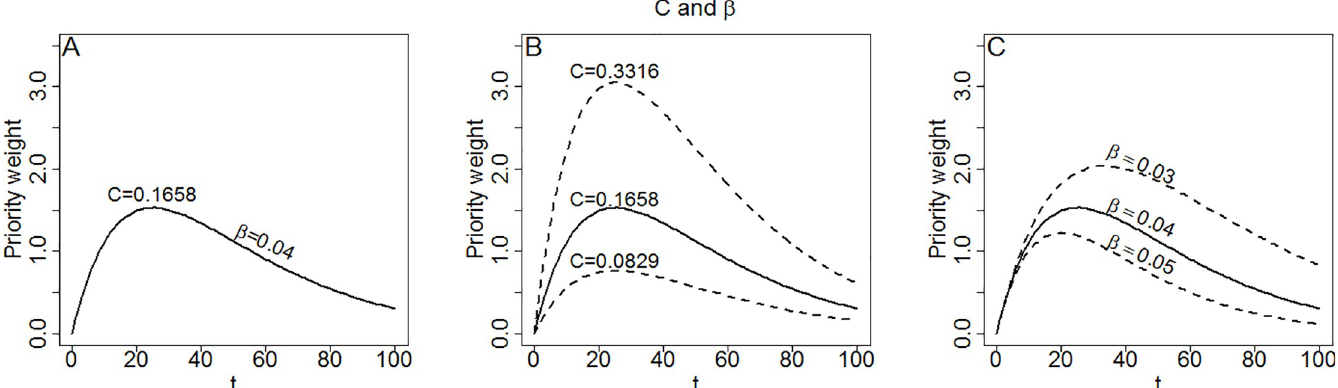
Fig 1. Properties of the coefficients of (5) when α = γ = 0. Panel A: Priority weights according to t. Panel B: Altering C causes an inflation or deflation. Panel C: Altering β changes the “pointyness” of the hump, causing the peak to become more or less pronounced.